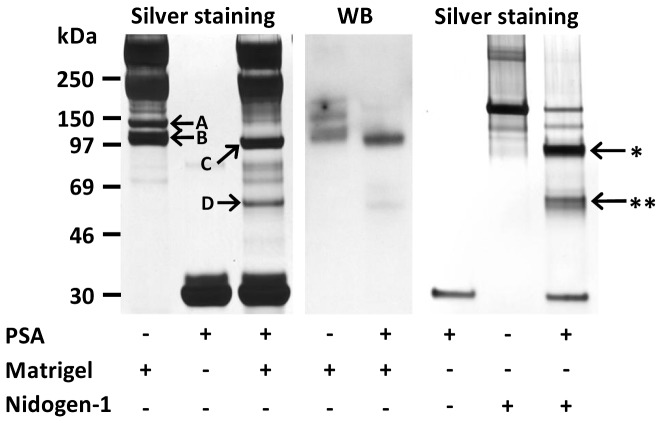
Degradation of nidogen-1 by PSA.PSA cleaved both mouse nidogen-1 in Matrigel and human recombinant nidogen-1. Mass spectrometry analysis identified nidogen-1 in the silver stained gel bands (arrows, left panel). Nidogen-1 bands of 140 kDa (A) and 110 kDa (B) disappeared and fragments of 90 kDa (C) and 55 kDa (D) appeared after 48 h incubation of diluted Matrigel with PSA at 37°C. Nidogen-1 cleavage by PSA in Matrigel was visualized by Western blotting with anti-nidogen-1 polyclonal antibody (middle panel). PSA (1 µM) cleaved recombinant human nidogen-1 (0.5 µM) into two fragments 85 kDa (arrow with *) and 55 kDa (arrow with **) during 20 h incubation at 37°C (right panel).